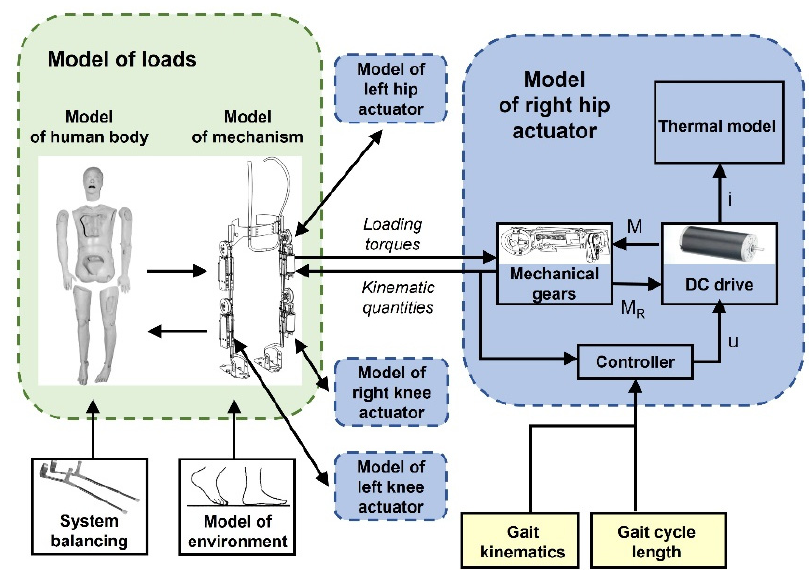
Figure 3. The structure of the simulation model.